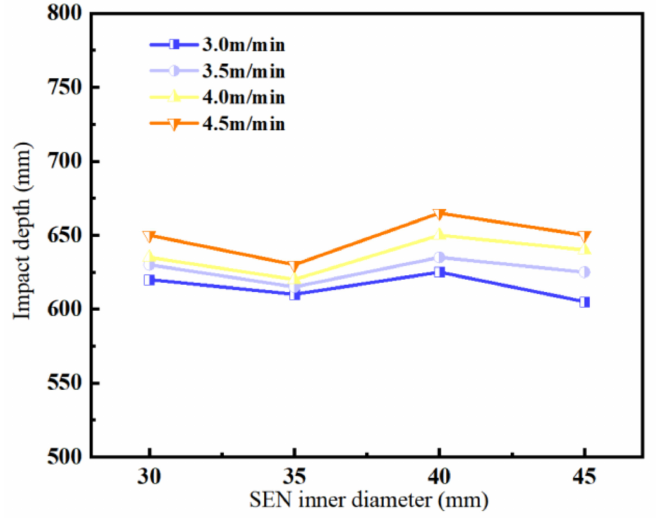
Figure 6. The relationship between the impact depth of molten steel and the inner diameter of